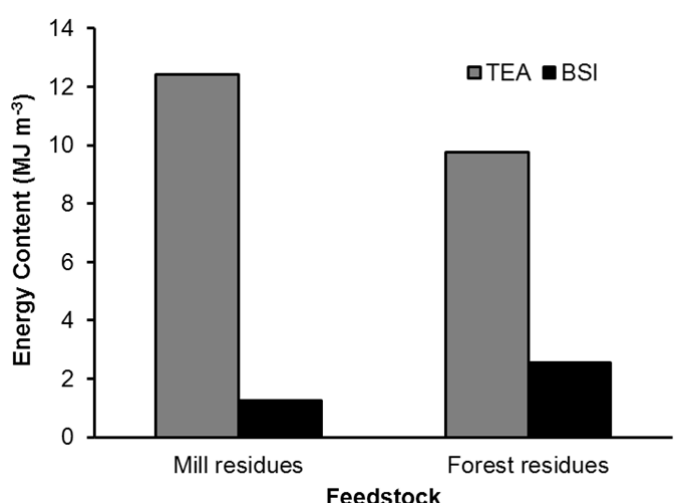
Figure 3. Gas energy content.